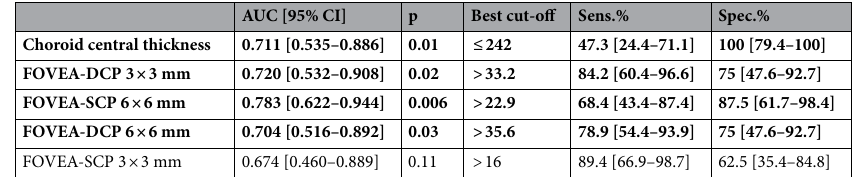
Table 5. Areas under the curve (AUCs) and best cut-off values (Youden index) of OCT-A parameters to detect patients with intradialytic hypotensive episodes. FAZ foveal avascular zone, SCP superficial capillary plexus. Statistically significant AUCs are highlighted in bold.